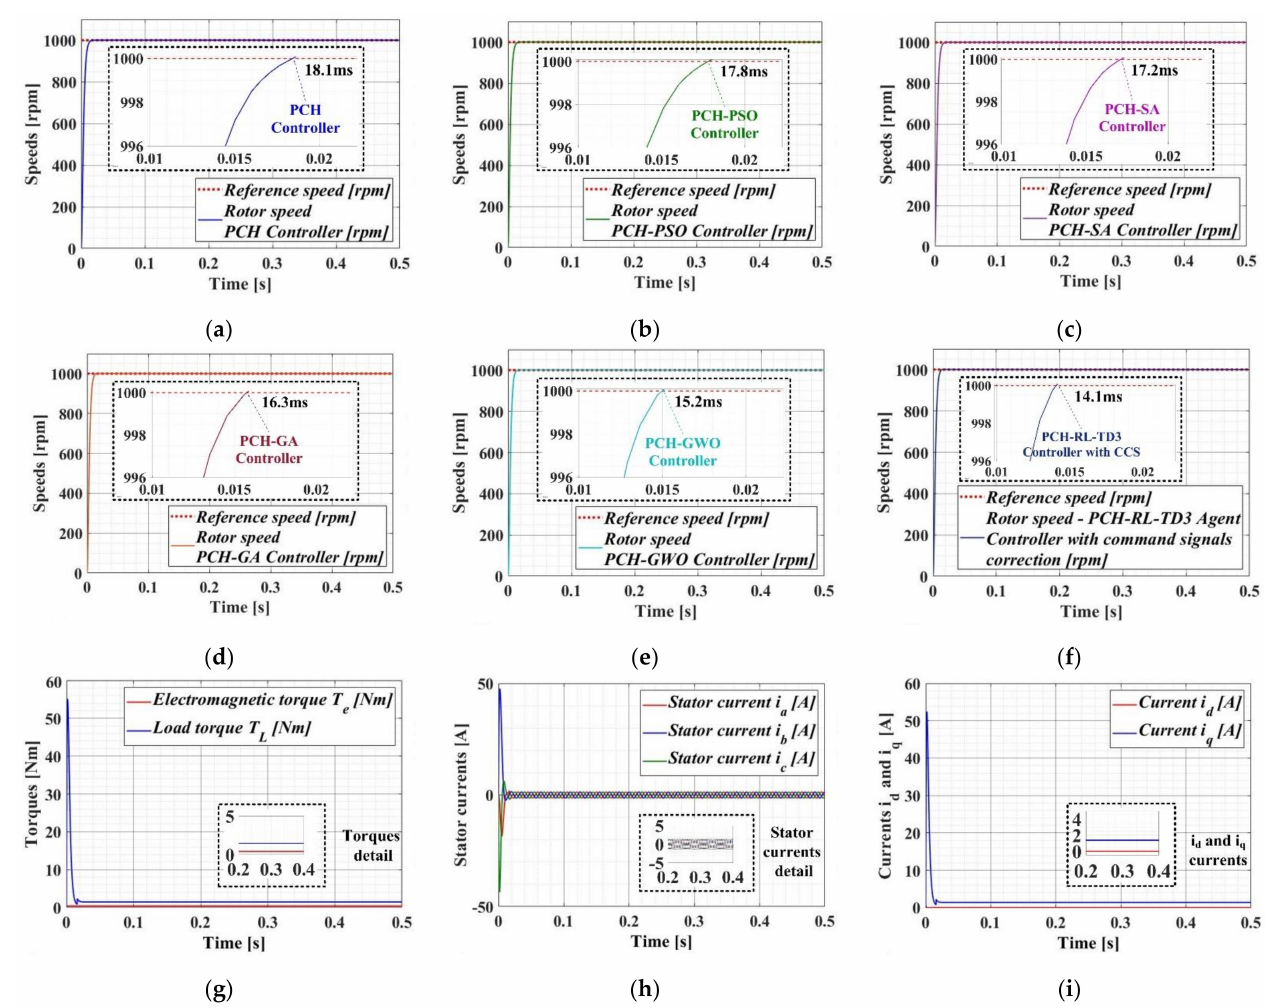
Figure 22. Time evolution parameters of the PMSM–CS–CI based on the PCH-type controller: ( a ) rotor speed—PCH; ( b ) speed—PCH–PSO; ( c ) speed—PCH–SA; ( d ) speed—PCH–GA; ( e ) speed—PCH– GWO; ( f ) speed—PCH–RL–TD3 with CCSs; ( g ) electromagnetic and load torques; ( h ) stator currents i a , i b , and i c ; ( i ) currents i d and i q